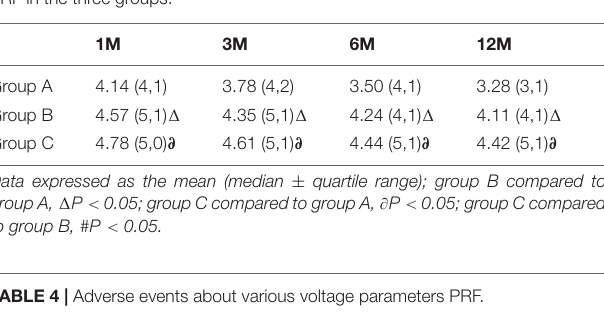
TABLE 3 | Likert scale five-point scoring system: global perceived effect; after PRF in the three groups. 1M 3M 6M 12M